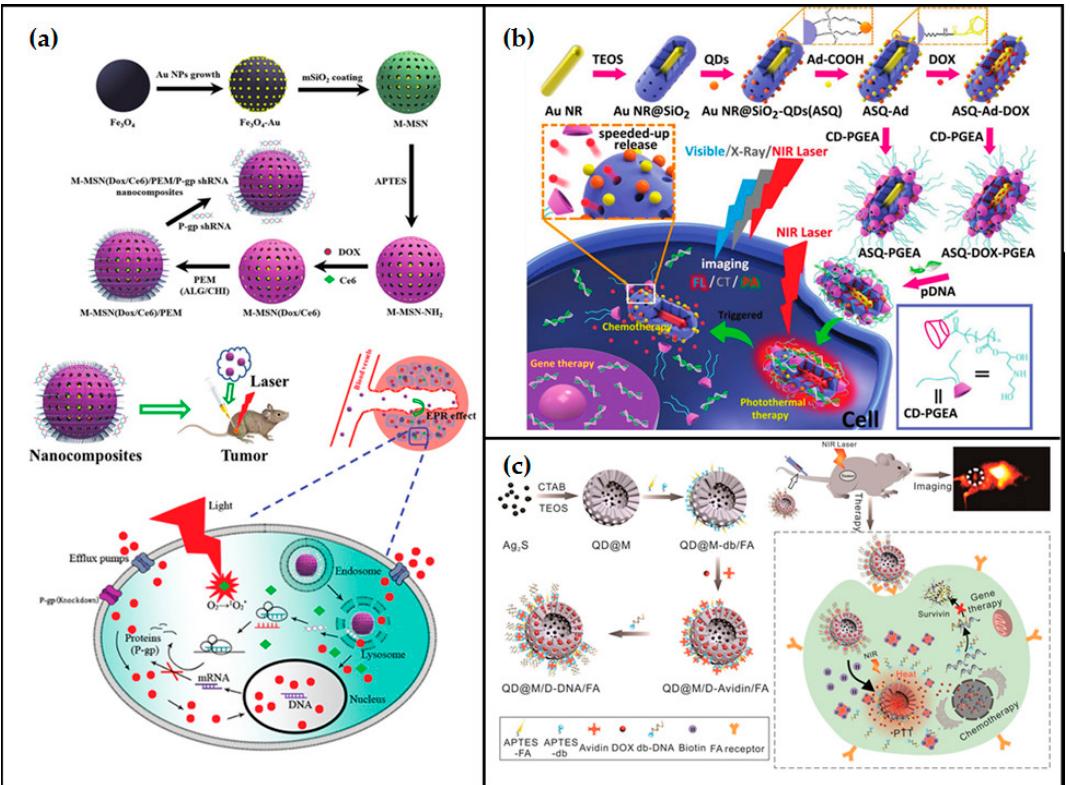
Figure 19. Illustration of silica-based nanocomposites for chemo/photo/gene therapy obtained by combining several different organic and inorganic materials: ( a ) Preparation of magnetic MSNs coated with alginate / chitosan polyelectrolyte multilayers and carrying DOX, Ce6 and P-gp shRNA, and their intracellular pH-triggered release in tumor cells (reproduced from [124], with permission from The Royal Society of Chemistry); ( b , c ) Preparation and working principle of multimodal imaging-guided therapeuticplatforms(( b )adaptedfrom[125], withpermissionfromJohnWileyandSons; ( c )reproduced from [126], with permission from Ivyspring International